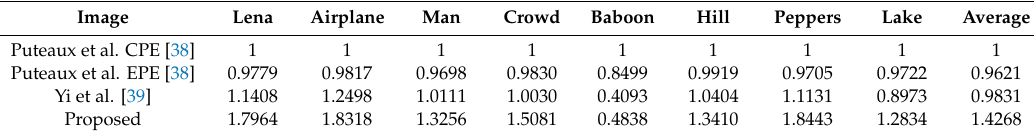
Table 4. Maximumembeddingratecomparisonbetweentheproposedmethodwithmethods[38,39](bpp). Image